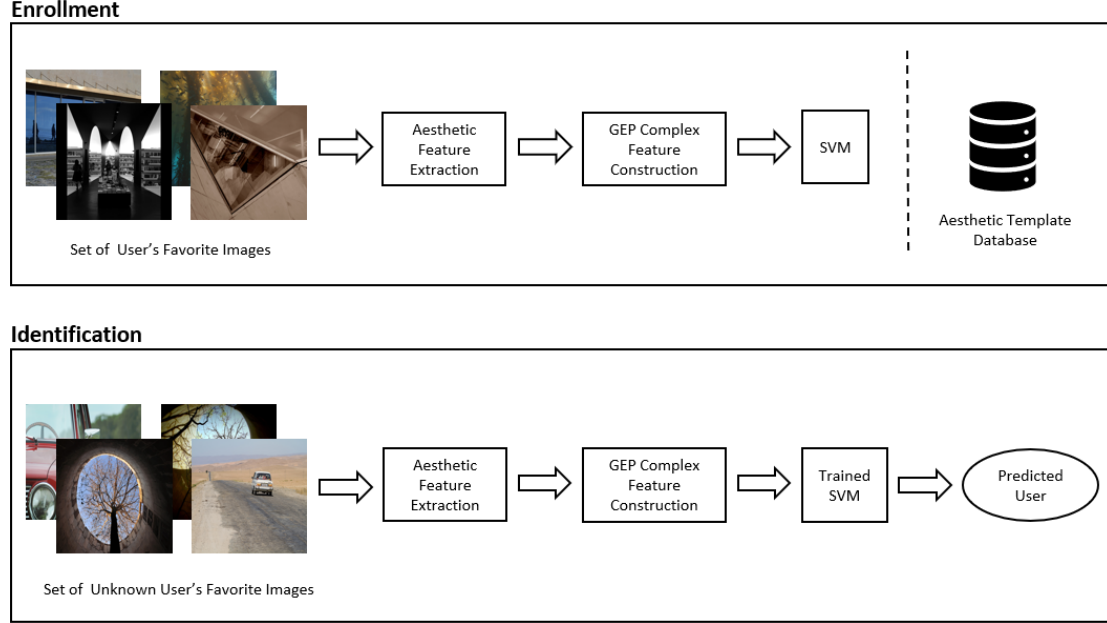
Figure 1. Enrollment and identification phases of the visual aesthetic-based identification